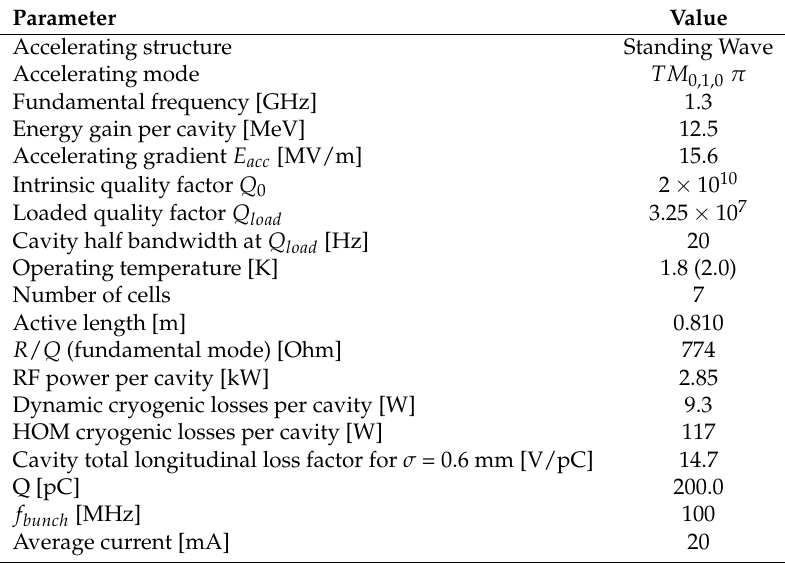
Table 1. BriXS cavity operational parameters.